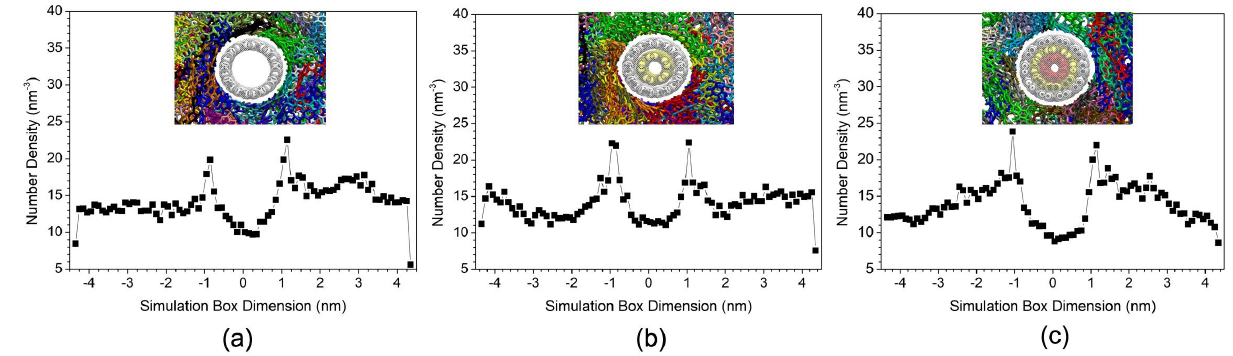
Figure 2: Equilibrated multi-chain systems and their density plots of the PI polymers interacting with a (a) SWCNT; (b) DWCNT; (c) TWCNT